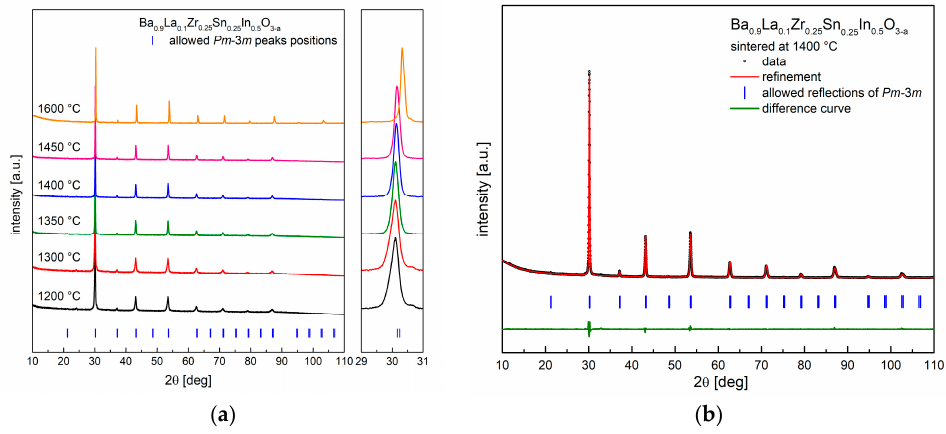
Figure 1. ( a ) X-ray diffraction (XRD) data recorded at room temperature (RT) for samples sintered at different temperatures; ( b ) XRD diffractogram with Rietveld refinement for Ba 0.9 La 0.1 Zr 0.25 Sn 0.25 In 0.5 O 3 − a sintered at 1400 ◦ C.